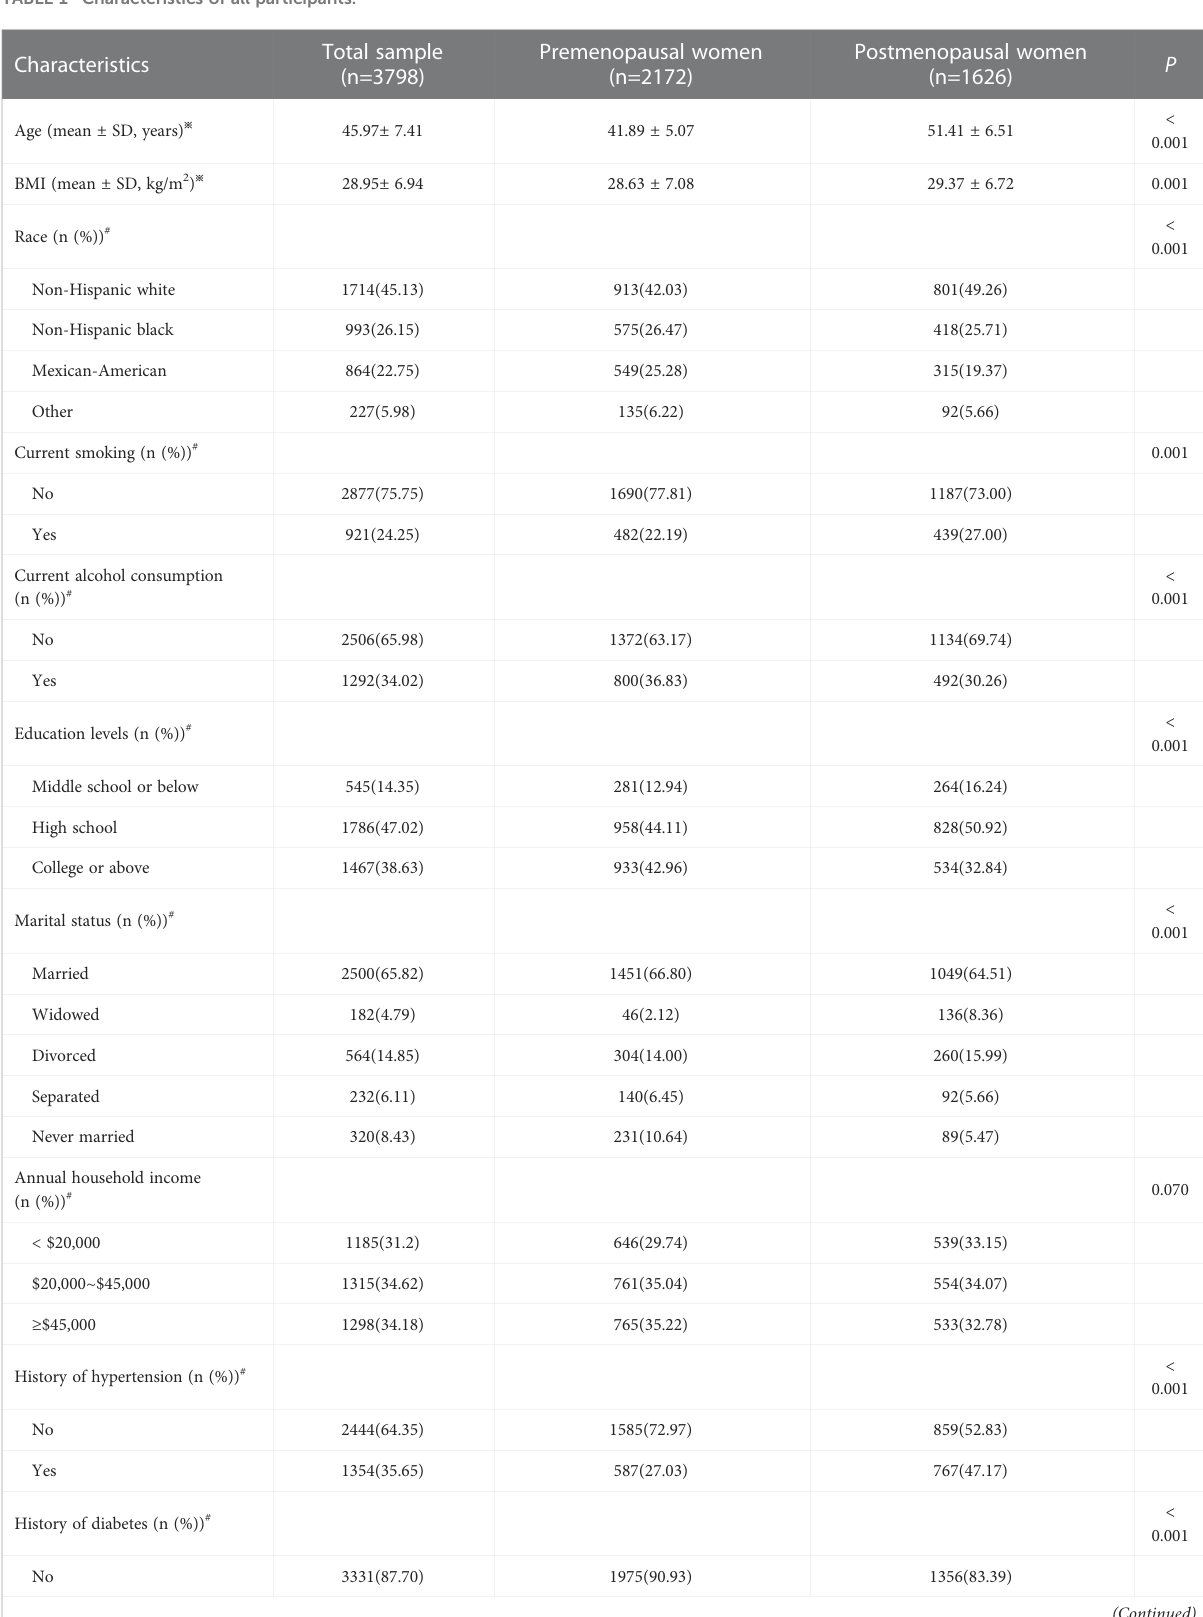
TABLE 1 Characteristics of all